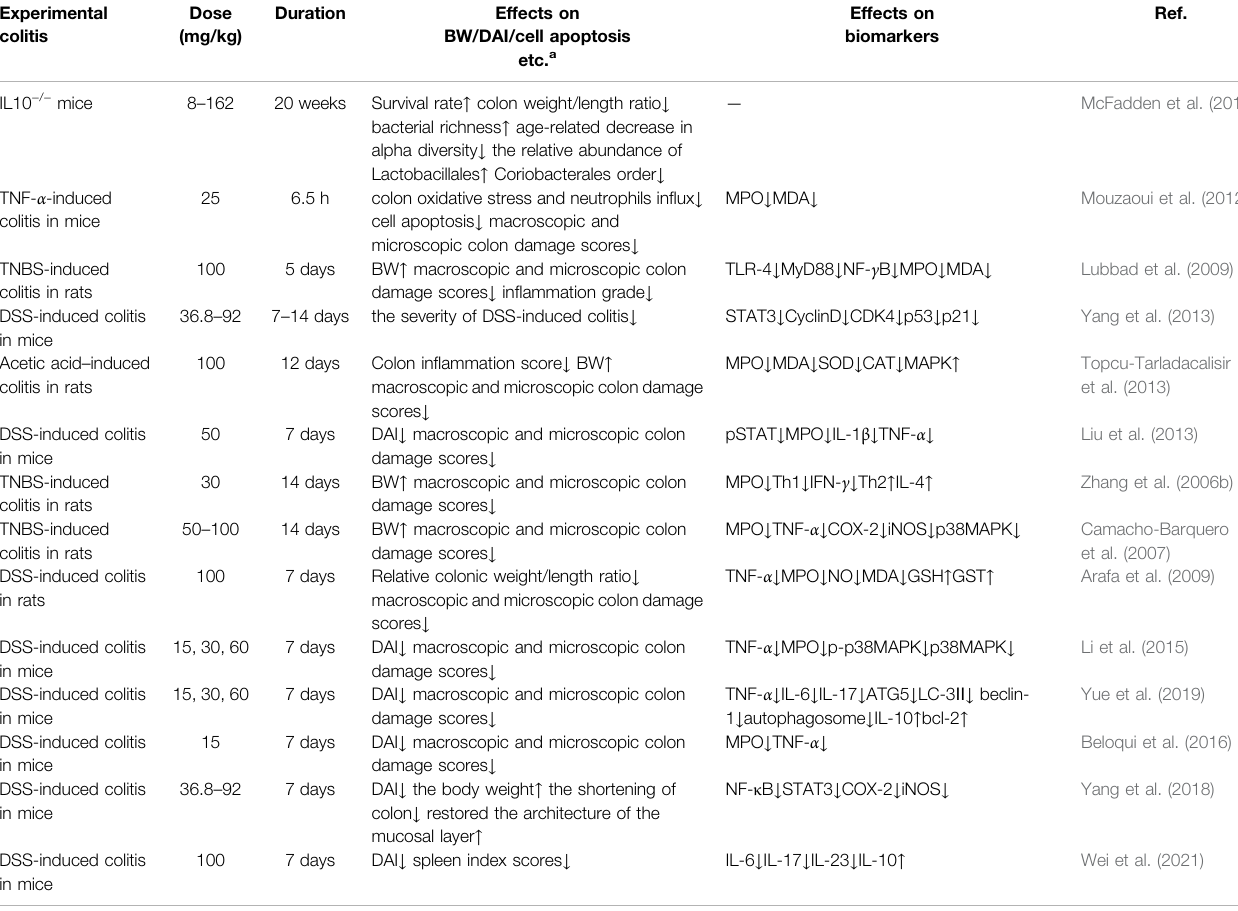
a BW: body weight, DAI: disease activity